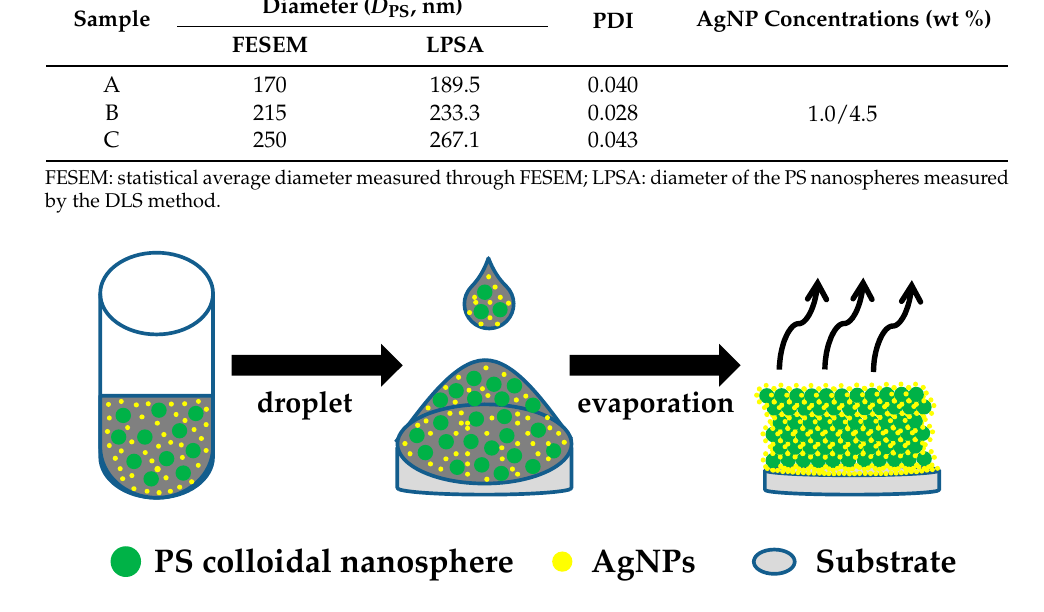
Figure 2. Schematic of the thermallyassisted self-assembly process through gravitational sedimentation method.